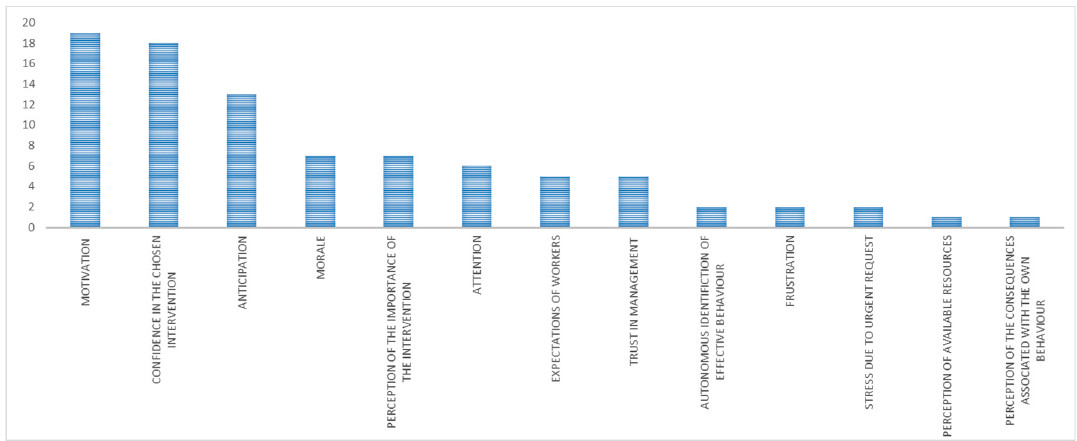
Figure 7. Main mechanisms (in terms of number of occurrences) in technical interventions with expected outcome.